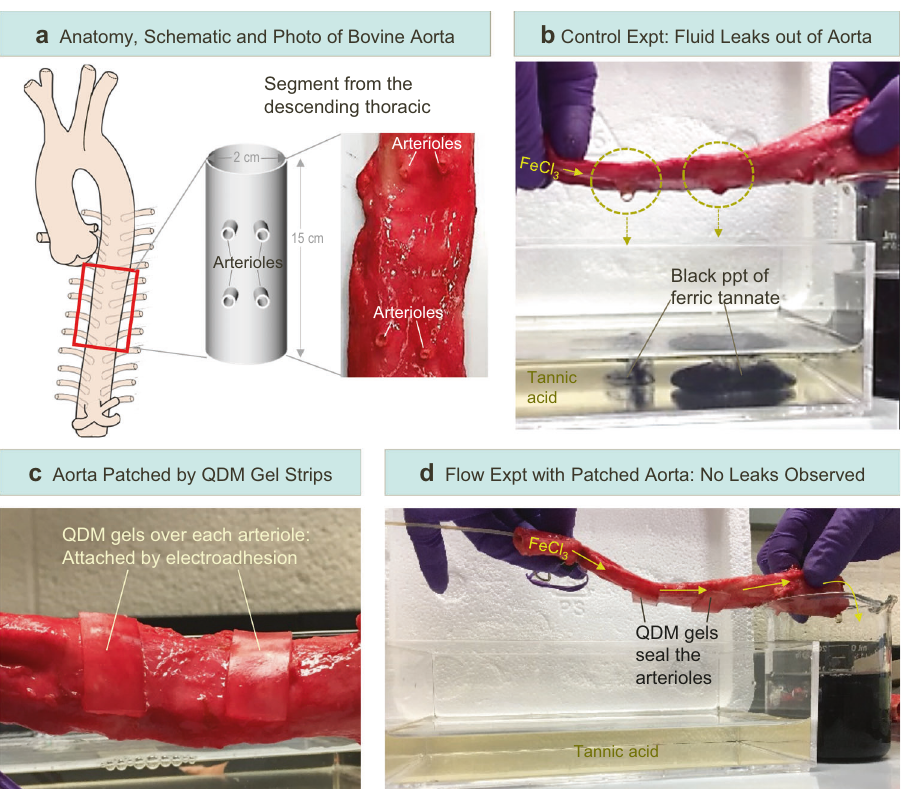
Fig. 7 Electroadhesion of QDM gels to patch openings in the aorta. a The anatomy of the aorta, which is a large artery, is depicted on the left. A 15-cm long segment from the descending thoracic region of the aorta is used in the study. The segment is a hollow tube that has holes on its surface corresponding to arterioles (side branches), as shown both in the schematic and the photo. b When an aqueous solution of 0.1 wt% FeCl 3 is pumped through the aorta, the fl uid leaks out of the arterioles and falls into the bath containing tannic acid, whereupon a black precipitate of ferric tannate is formed. c Two QDM gel strips are electroadhered to the aorta so as to cover the arterioles. d When the FeCl 3 solution is pumped through the patched aorta, no leaks are observed (the bath stays clear), and the fl uid fl ows steadily into the beaker on the right. The entire process is depicted in Supplementary Movie